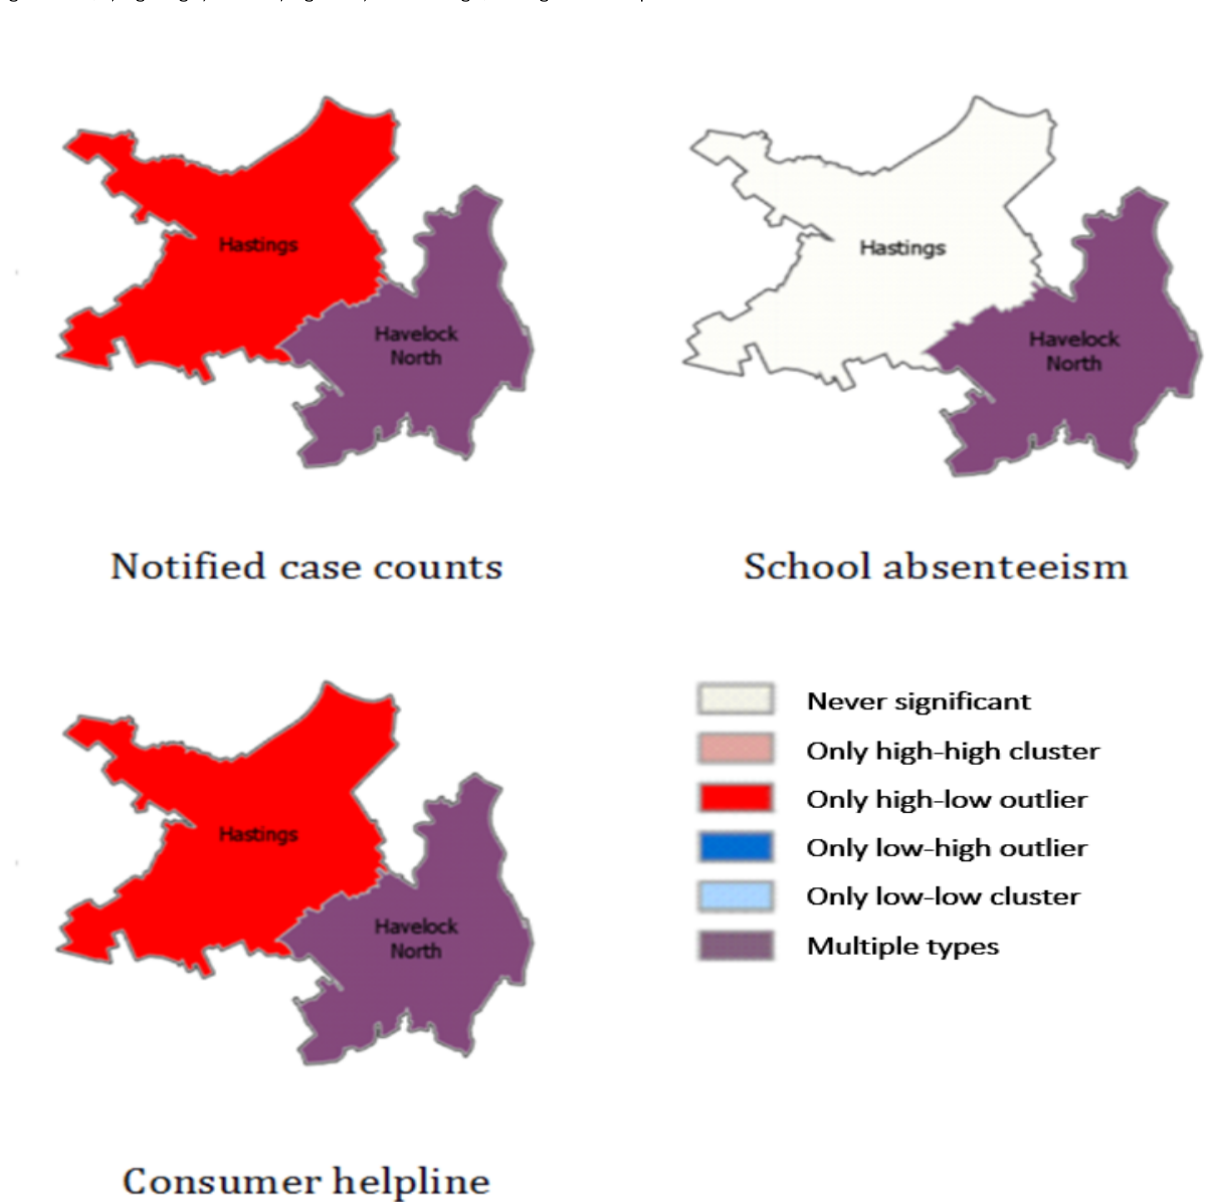
Figure 3. Cluster types in notified case counts, consumer helpline inquiries, and school’s absenteeism in Hastings and Havelock North. High-high cluster refers to high values surrounded by high values, high-low cluster refers to high values surrounded by low values, low-high cluster refers to low values surrounded by high values, and low-low cluster refers to low values surrounded by low values. Multiple Types refer to multiple cluster-type designations (ie, high high, low low, high low, and low high) through the time